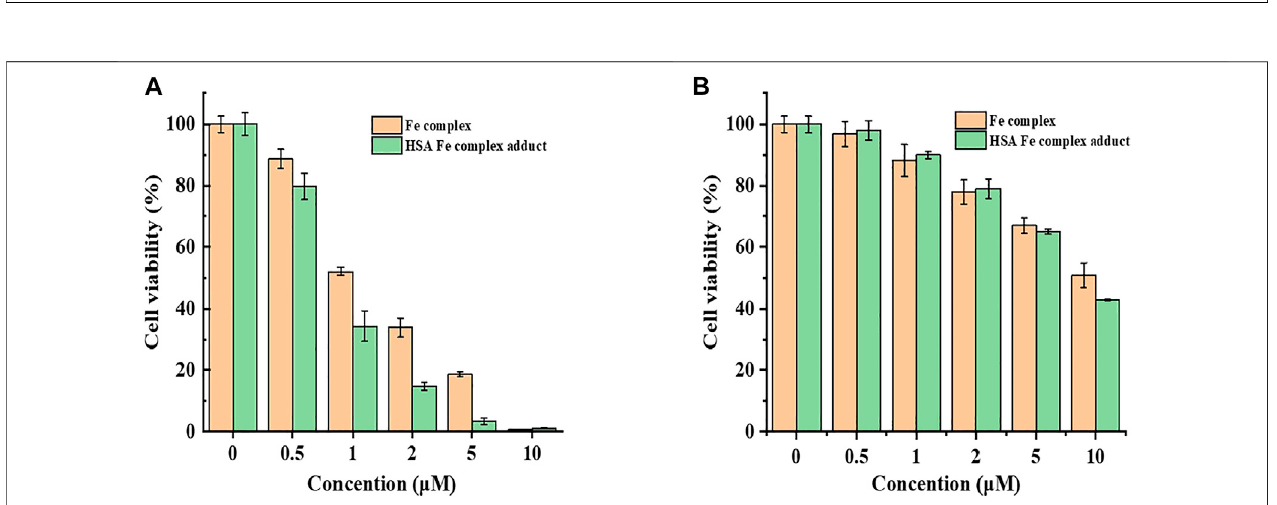
Frontiers in Chemistry |